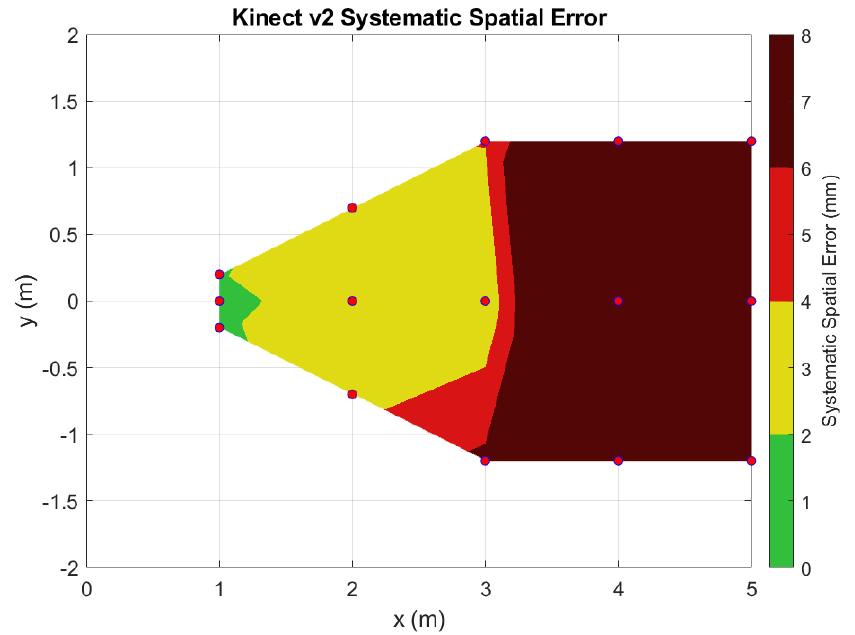
Figure 12. Random depth error for the Azure Kinect, where 𝑑̅ indicates the average depth value and 𝐸 (cid:3045) is the standard deviation, or the random depth error. The horizontal axes and titles are in units of millimeters, while the vertical axes indicate bin counts. Each bin is 1 mm in width.